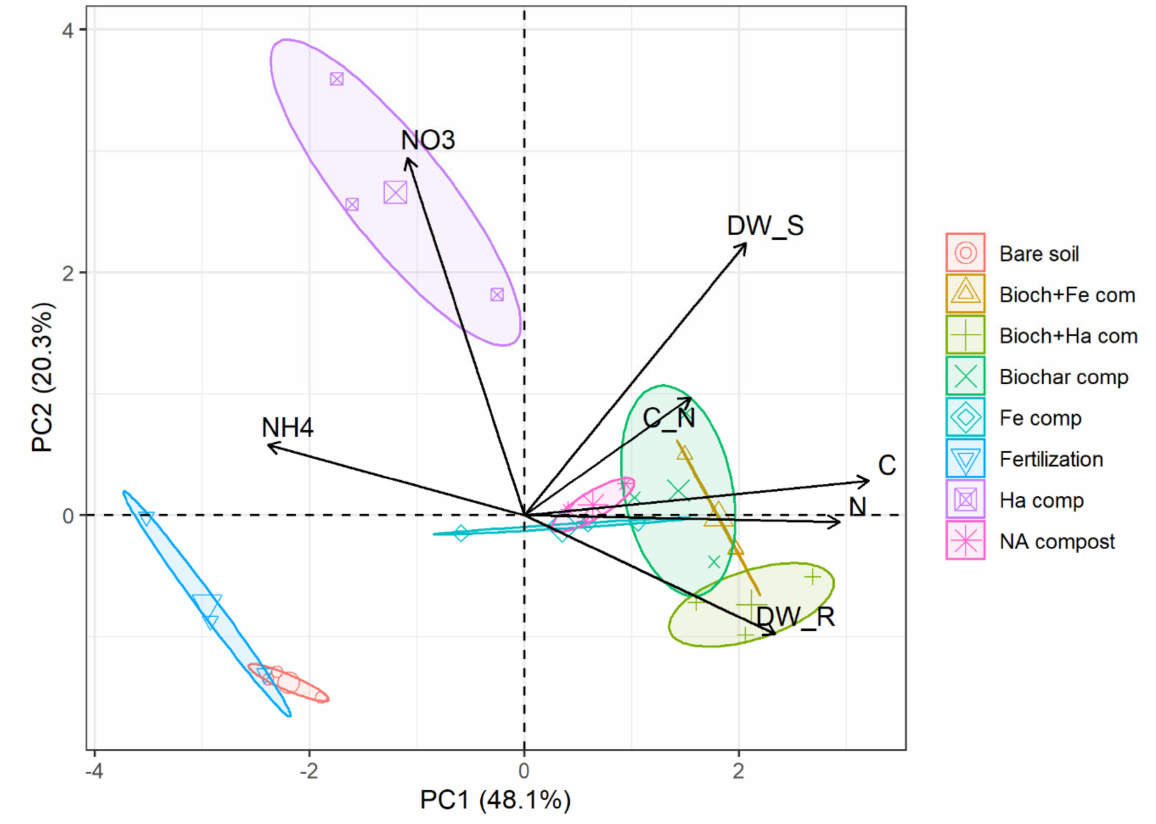
Figure 5. Principal component (PC) analysis of the response variables total C, N and C/N atomic ratio, NH 4+ and NO 3 − concentration, and dry weight roots and shoots (DW_R and DW_S,